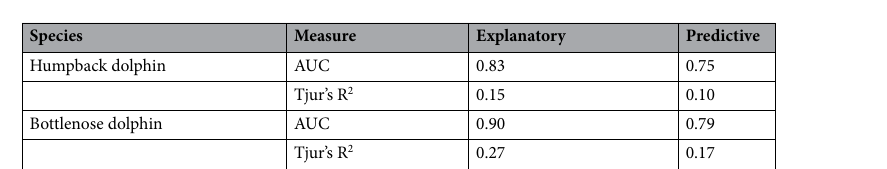
Table 3. The explanatory and predictive power of the joint species distribution model of Australian humpback ( Sousa sahulensis ) and Indo-Pacific bottlenose dolphins ( Tursiops aduncus ) around the North West Cape, Western Australia, as measured by the area under the curve (AUC) and Tjur’s R 2 statistics.